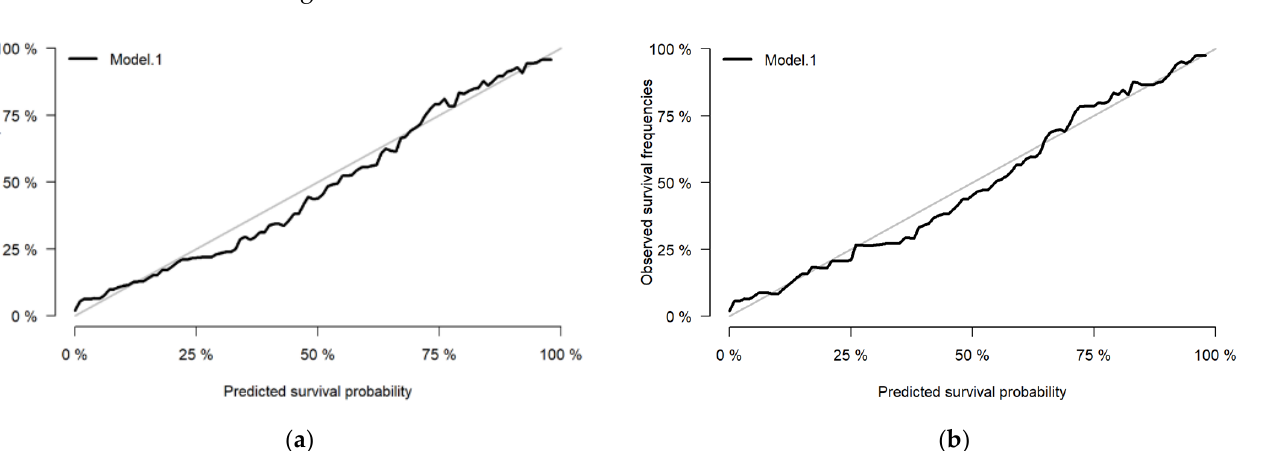
Figure 3. The calibration plots show a well-calibrated Cox PH model for ( a ) the derivation dataset and ( b ) the validation dataset between observed and predicted survival probabilities. Calibration plots (black line) along the 45-degree line (grey line) indicate a perfect calibration model in which the predicted survival probabilities are identical to the observed survival outcomes.